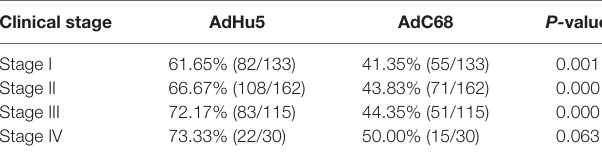
Table 5 | Seroprevalence of AdHu5 and AdC68 neutralizing antibodies in subjects with different clinical stage of cancer. clinical stage